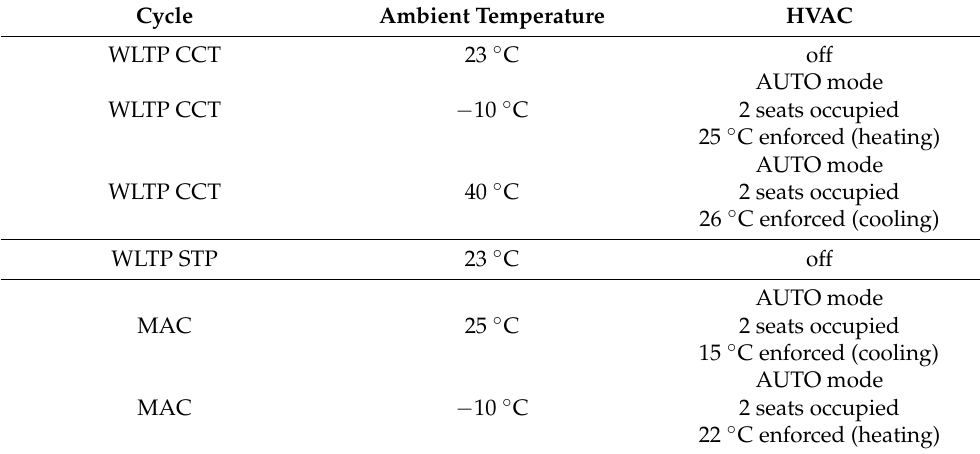
Table 3. Laboratory and on-road driving tests.